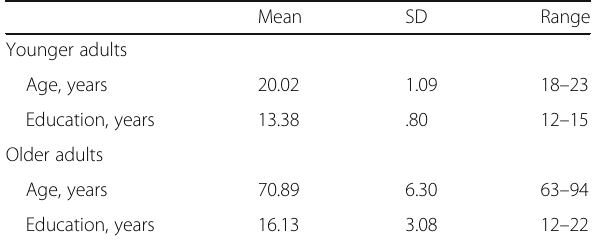
Table 1 Participant age and education as a function of age